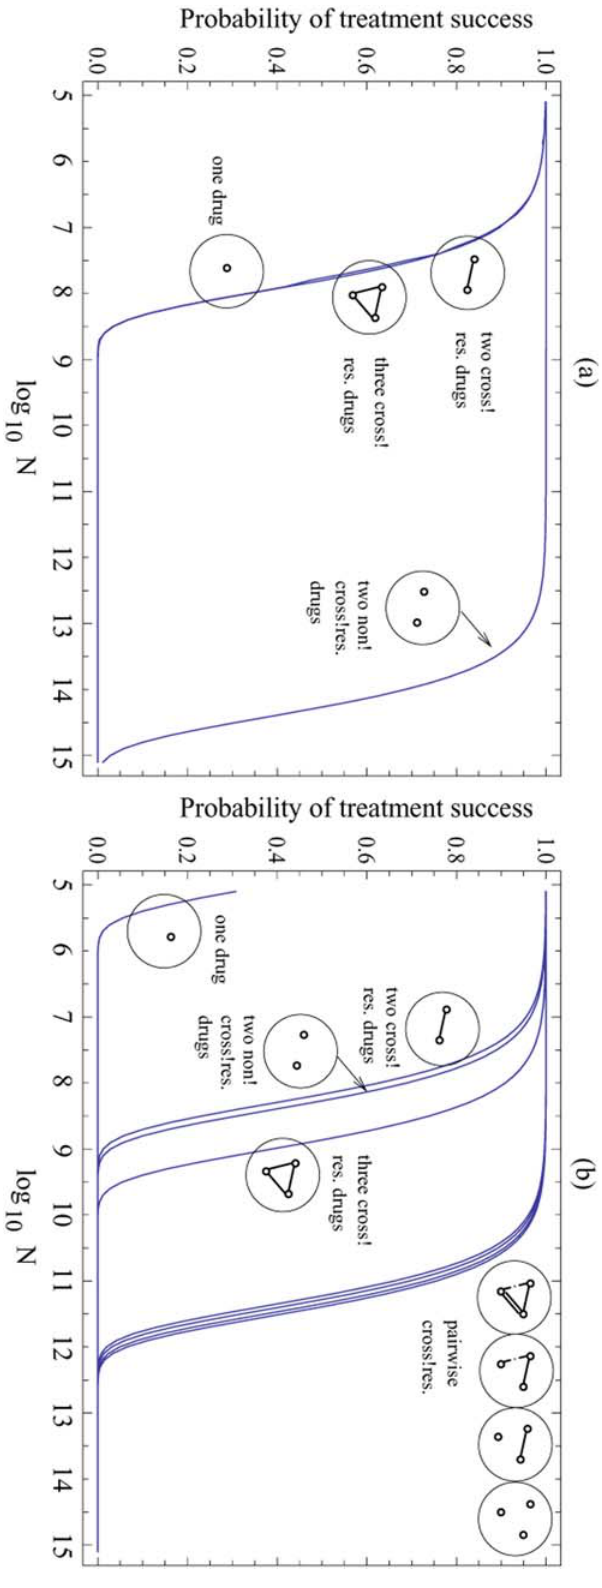
Figure 2. The probability of treatment success is plotted as a function of the colony size, N . (a) The number of non-cross-resistant mutations is low ( k=10 ) and the mutation rate for cross-resistance is 10 times higher than in figure 1. Conclusion: combining more than one